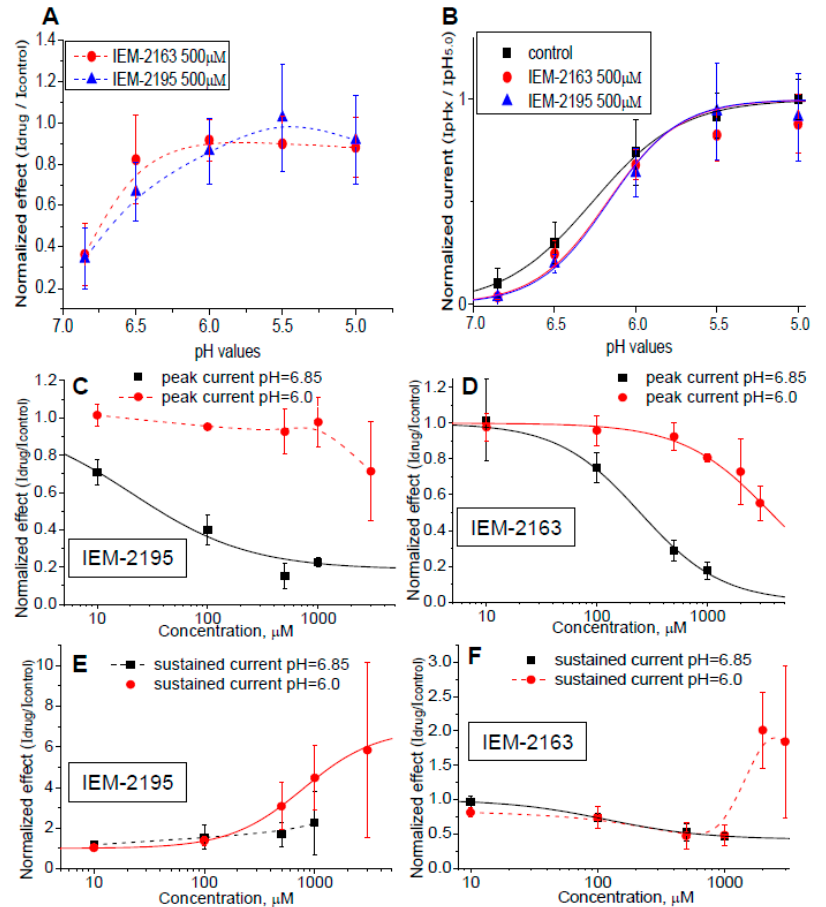
Figure 3. pH and concentration dependencies of IEM-2163 and IEM-2195 action. ( A ) Peak current inhibition was pH-dependent, the effects of both drugs disappeared under strong acidification. ( B ) IEM-2163 and IEM-2195 caused acidic shift of the ASIC3 activation curve. ( C – F ) Concentration dependencies of IEM-2163 ( D , F ) and IEM-2195 ( C , E ) action on peak ( C , D ) and sustained ( E , F ) currents. Fitting is shown in solid lines. Note that the concentration dependence of IEM-2163’s action on sustained current was biphasic at pH 6.0 where the current inhibition was small. Low concentrations caused inhibition, but at high concentrations the effect was